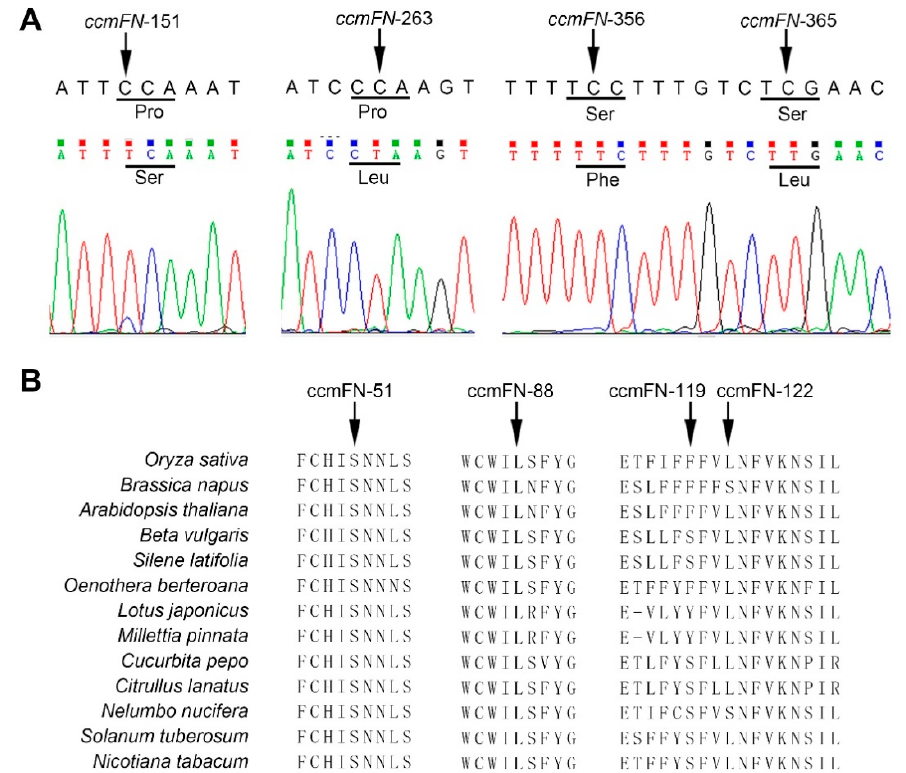
Figure 3. Identification of novel RNA editing sites in rice mitochondria-encoded ORFs. ( A ) Sequence chromatogram of PCR-amplified ccmFN cDNA. Arrow indicates the novel editing sites ccmFN- 151, ccmFN- 263, ccmFN- 356, and ccmFN- 365. Amino acids before and after editing are shown below the codons indicated by black lines. ( B ) Alignment of amino acid sequences from rice CcmFN and its orthologs from other plant species. The sequences of Oryza sativa , Citrullus lanatus , Lotus japonicus , Cucurbita pepo , Oenothera berteroana , Arabidopsis thaliana , Silene latifolia , Silene latifolia , Nelumbo nucifera and Millettia pinnata were retrieved from REDIdb and sequences of Nicotiana tabacum (BAD83458.2), Beta vulgaris (NP_063987.2) and Solanum tuberosum (QEQ76363.1) were downloaded from NCBI. All the sequences were aligned with Clustal Omega (http://www.ebi.ac.uk/Tools/msa/clustalo/) [34]. Arrows indicate the amino acids for rice CcmFN-51, CcmFN-88, CcmFN-119, and CcmFN-122 encoded by edited codons. Note that amino acid sequences from NCBI are translated from unedited transcripts.